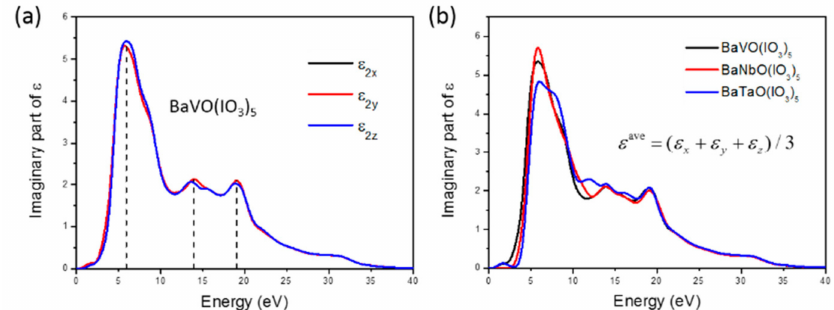
Figure 7. ( a ) Imaginary part ε 2 ( ω ) of the frequency-dependent dielectric function of BaVO(IO 3 ) 5 along different dielectric axes. ( b ) Averaged ε 2 ( ω ) of BaMO(IO 3 ) 5 (M = V, Nb and